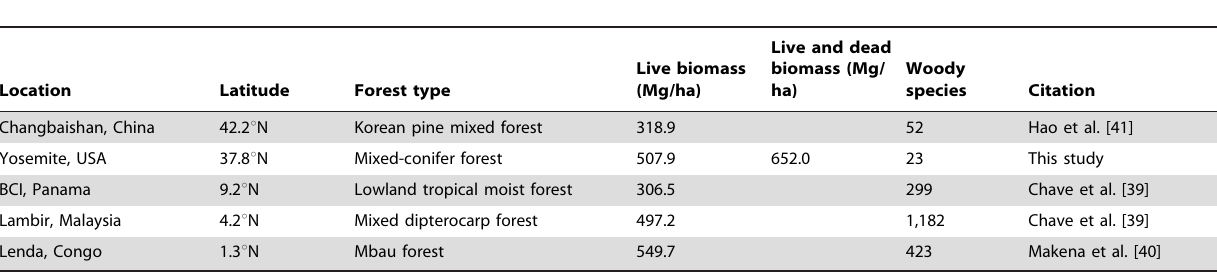
Table 4. Comparison of the Yosemite Forest Dynamics Plot with other Smithsonian CTFS-affiliated forest plots.